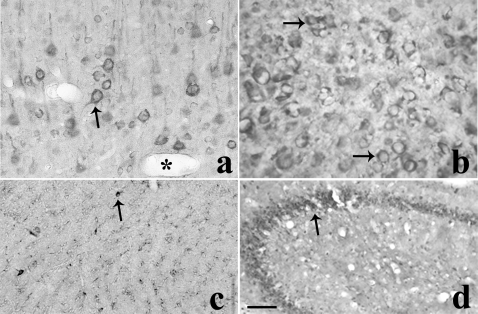
Brain CB2-Rs: Immunohistochemistry in mouse and rat brain.
A, CB2-IR in apical dendrites and cell bodies of pyramidal neurons of rat cerebral cortex. B, CB2-IR in mouse cerebral cortex. C, CB2-IR in rat corpus callosum and D, CB2-IR in mouse hippocampal allocortex and some interneurons in the striatum oriens and stratum radiatum.